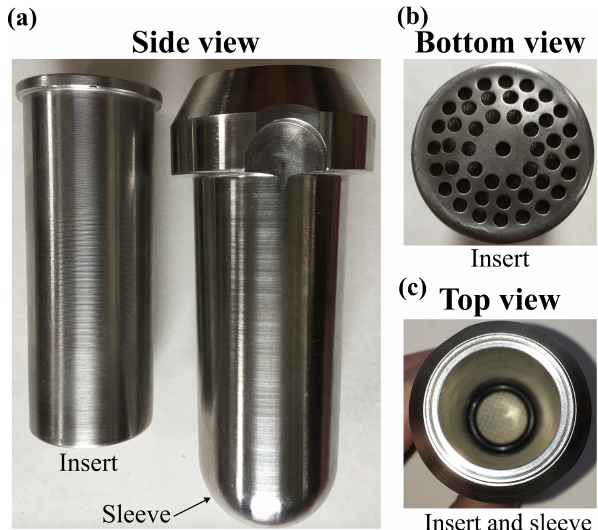
Figure 2. (a) Image of a custom-made centrifuge insert and Sorvall sleeve. (b) Bottom view of an insert perforated with drilled holes to allow water movement during centrifugation. (c) Top view of an insert and sleeve, including the steel screens at the bottom of the insert secured with a rubber o-ring to reduce soil loss during cen- trifugation. The steel tube inserts were fitted with a collar at the top that secured the position of the insert within the sleeve at roughly 19mm above the bottom to establish a reservoir for collecting ex- tracted water through the screens and perforated bottom. The small gravity-secured caps described in Sect. 2.2 are not shown in this